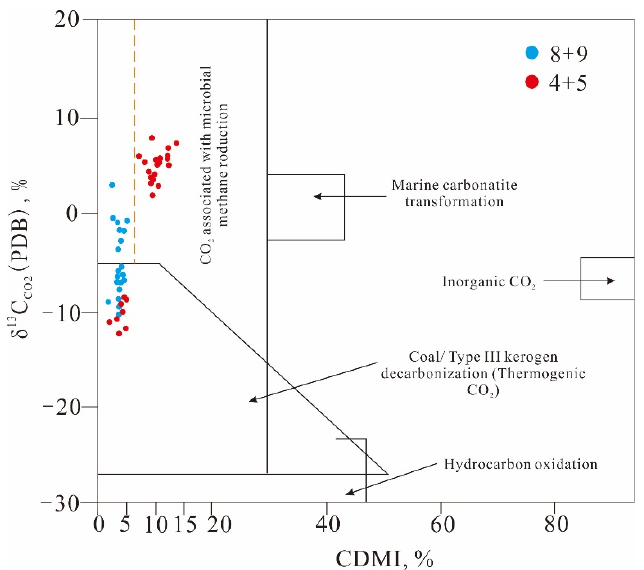
Figure 6. Relationship between δ 13 C (CO 2 ) and